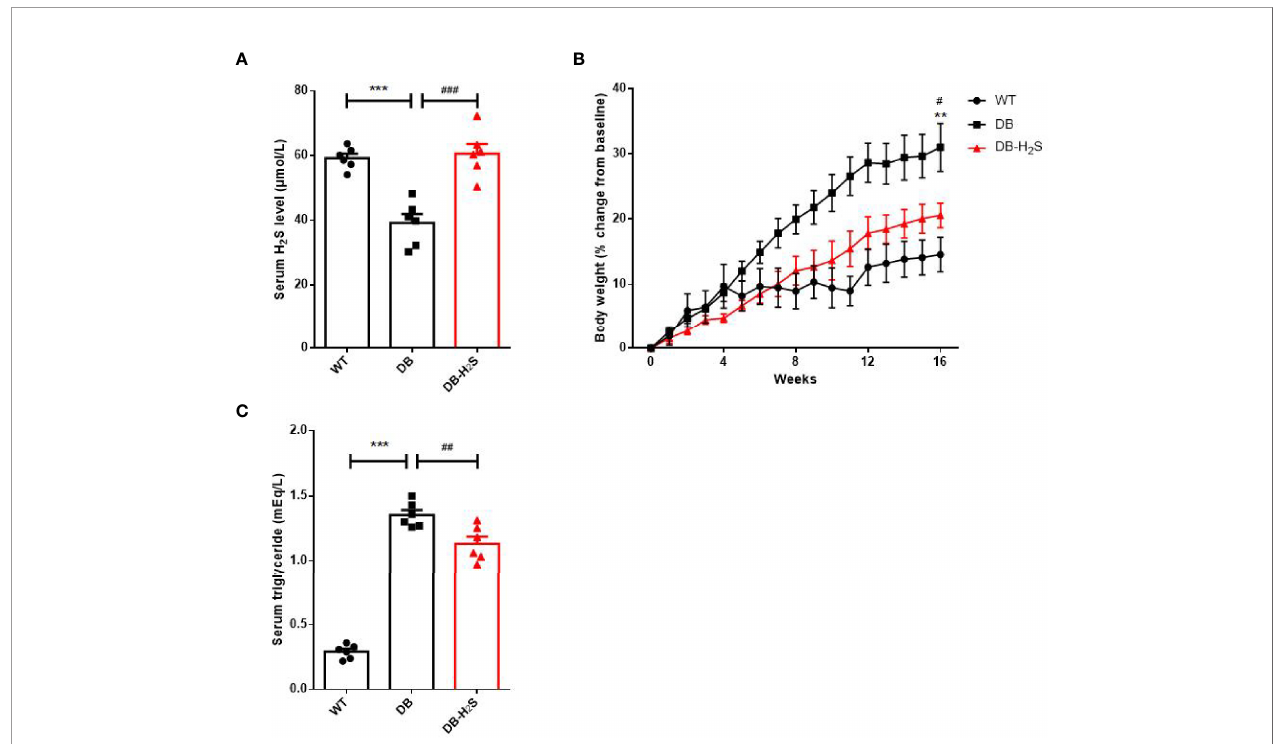
FIGURE 1 | Effects of exogenous H 2 S on serum H 2 S level and obesity parameters. (A) Serum H 2 S level at week 16. (B) Percent change in body weight from baseline over 16 weeks. (C) Serum triglyceride level at week 16. WT, wild-type mouse group (n = 6); DB, db/db mouse group (n = 6); and DB-H 2 S, db/db mouse treated with NaHS group (n = 6). Data are shown as mean ± SEM. Differences were analyzed by one-way ANOVA with Tukey ’ s multiple-comparison test and denoted as follows: ** p < 0.01, *** p < 0.001, WT vs. DB; # p < 0.05, ## p < 0.01, ### p < 0.001, DB-H 2 S vs.